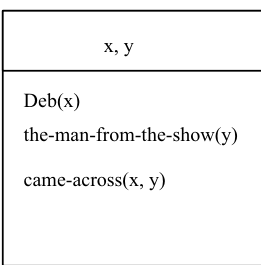
Figure 7: A DRS for the sentence ‘ Deb came across the man from the show ’ .